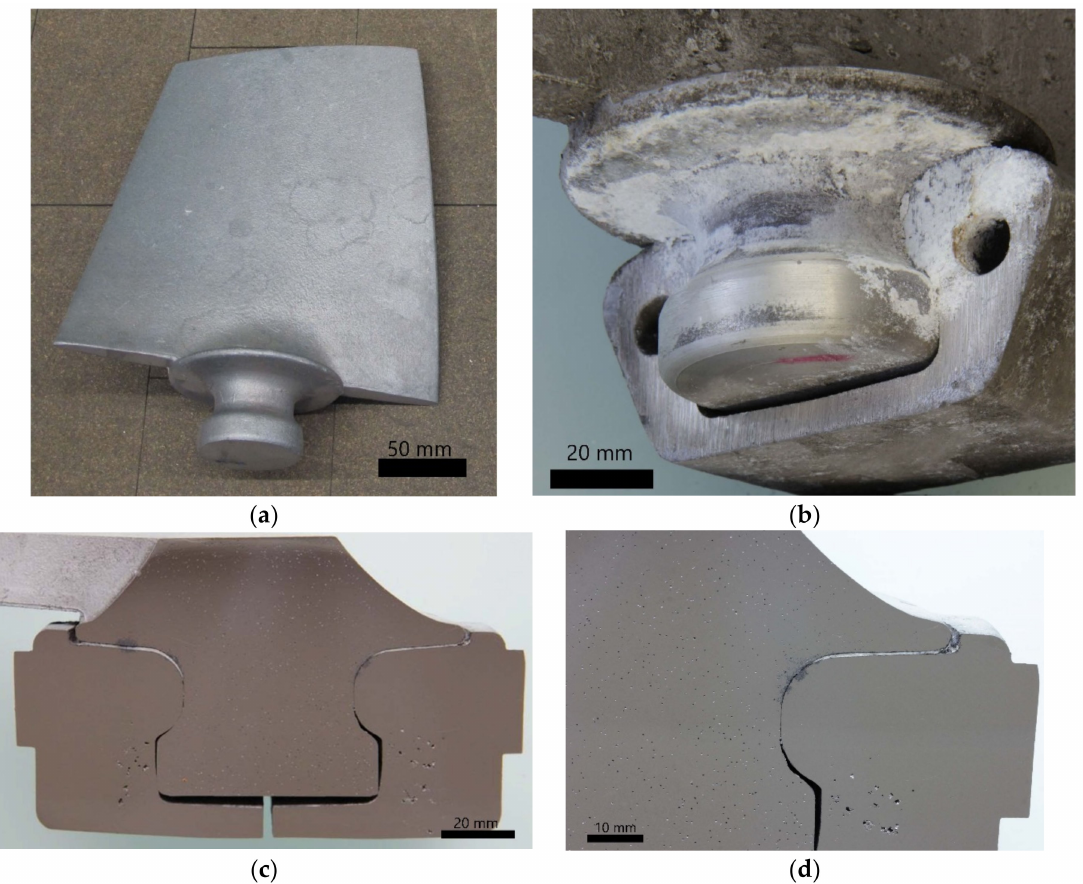
Figure 2. Blade and mounting detail: ( a ) new blade, ( b ) root, throat, and platform of the blade with one mounting block removed, ( c ) cross section of the assembly, and ( d ) gap filled with corrosion products between the root and the blade seat at the platform and the upper part of the throat (detail of ( c